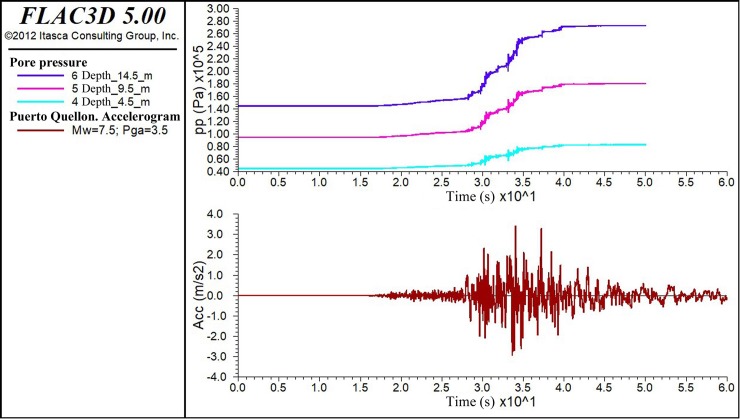
Evolution of the pore pressures vs. input accelerogram for Puerto Quellon (PQ).